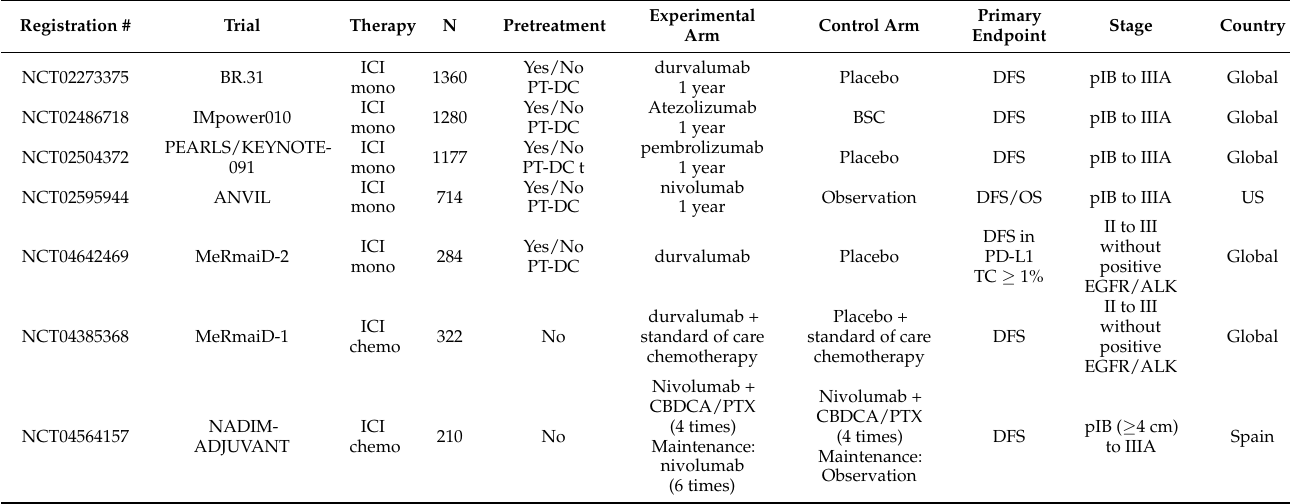
Table 1. Phase 3 clinical trials of adjuvant therapy using